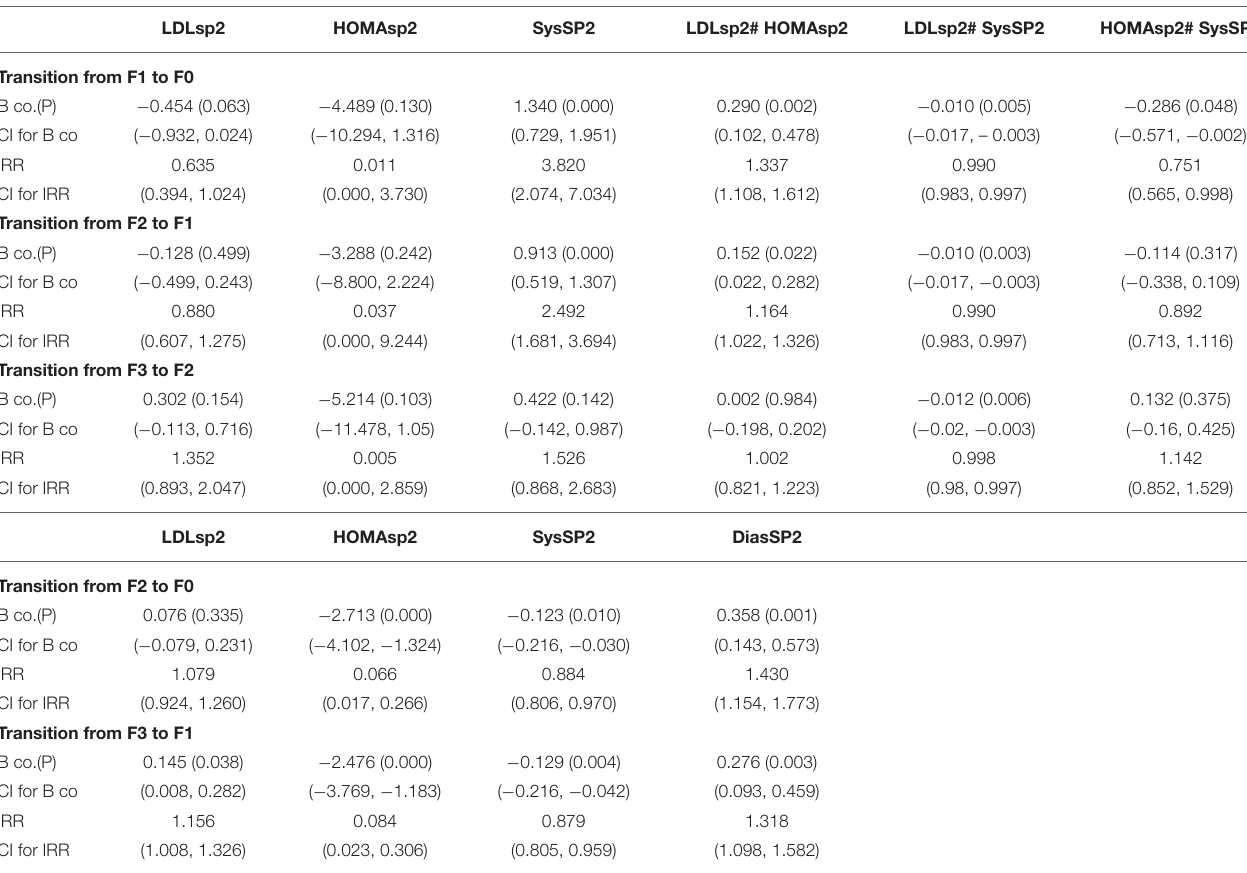
TABLE 5 | Parameters for each